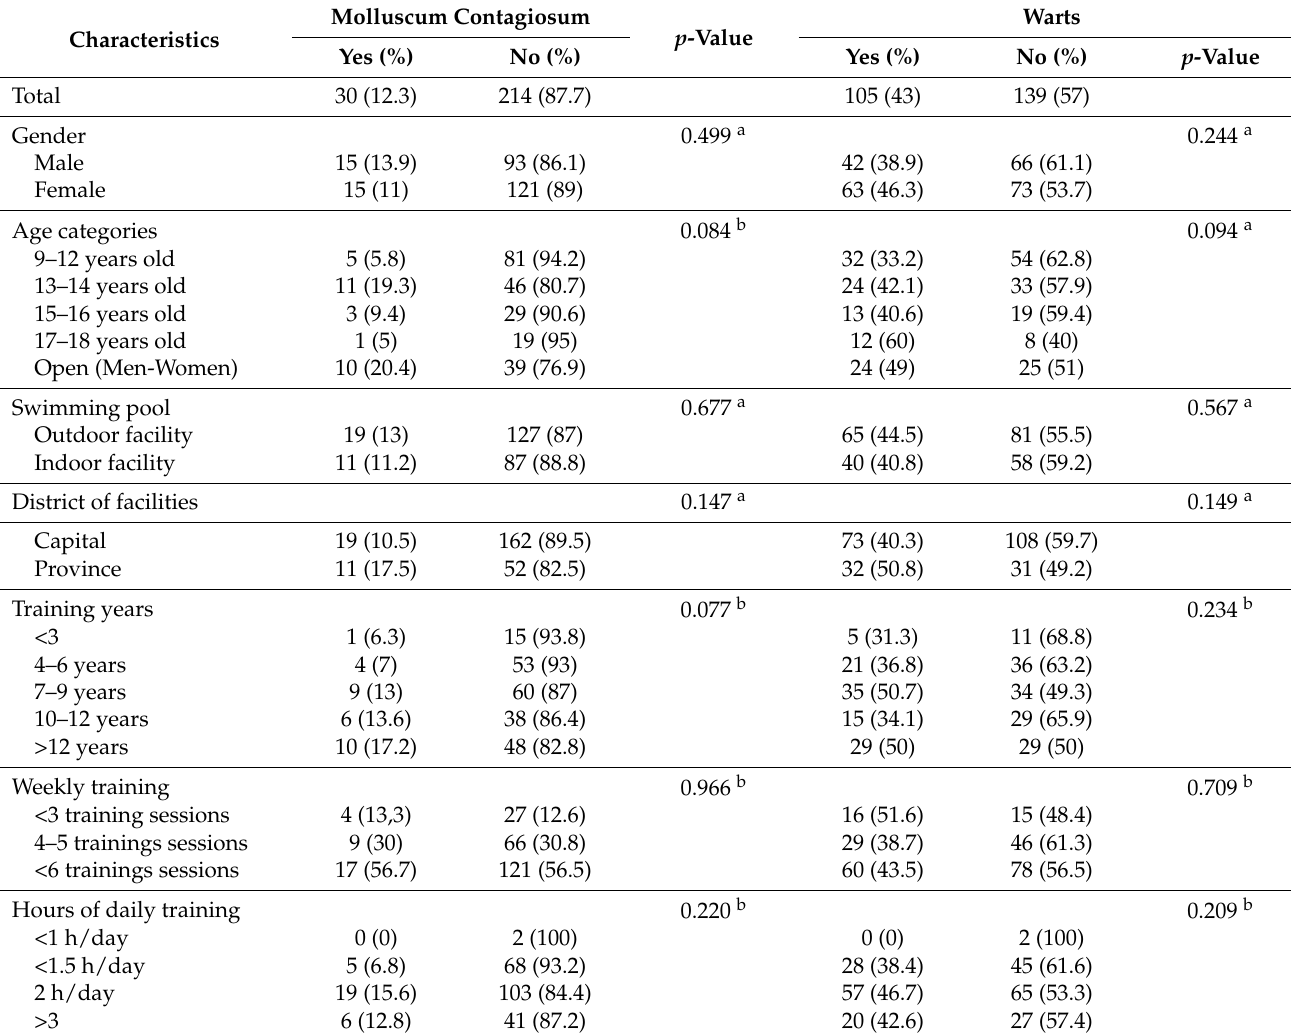
Table 1. Bivariate analyses using molluscum contagiosum and warts as dependent